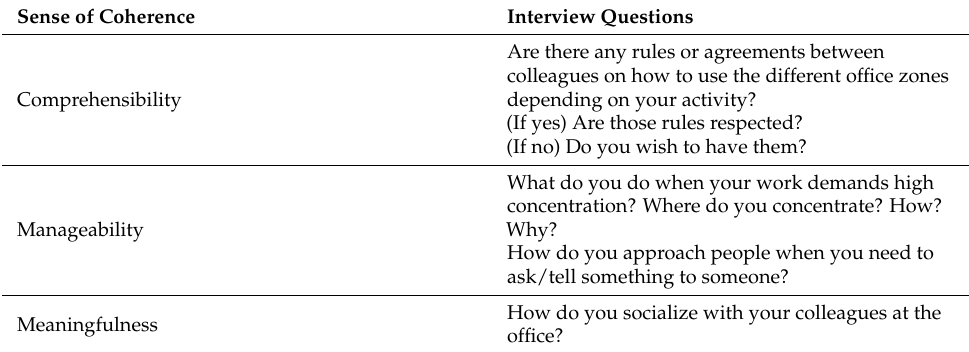
Table 2. Sample questions from the interviews in relation to